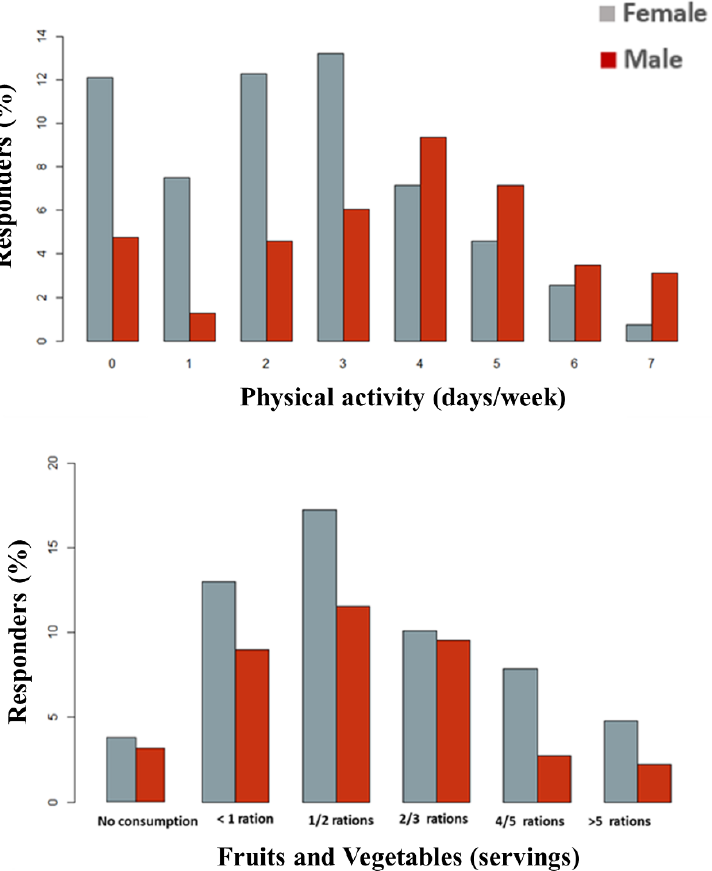
Figure 2. Physical exercise (days/week) and consumption of fruits and vegetables (servings/day) among the study participants stratified by sex.